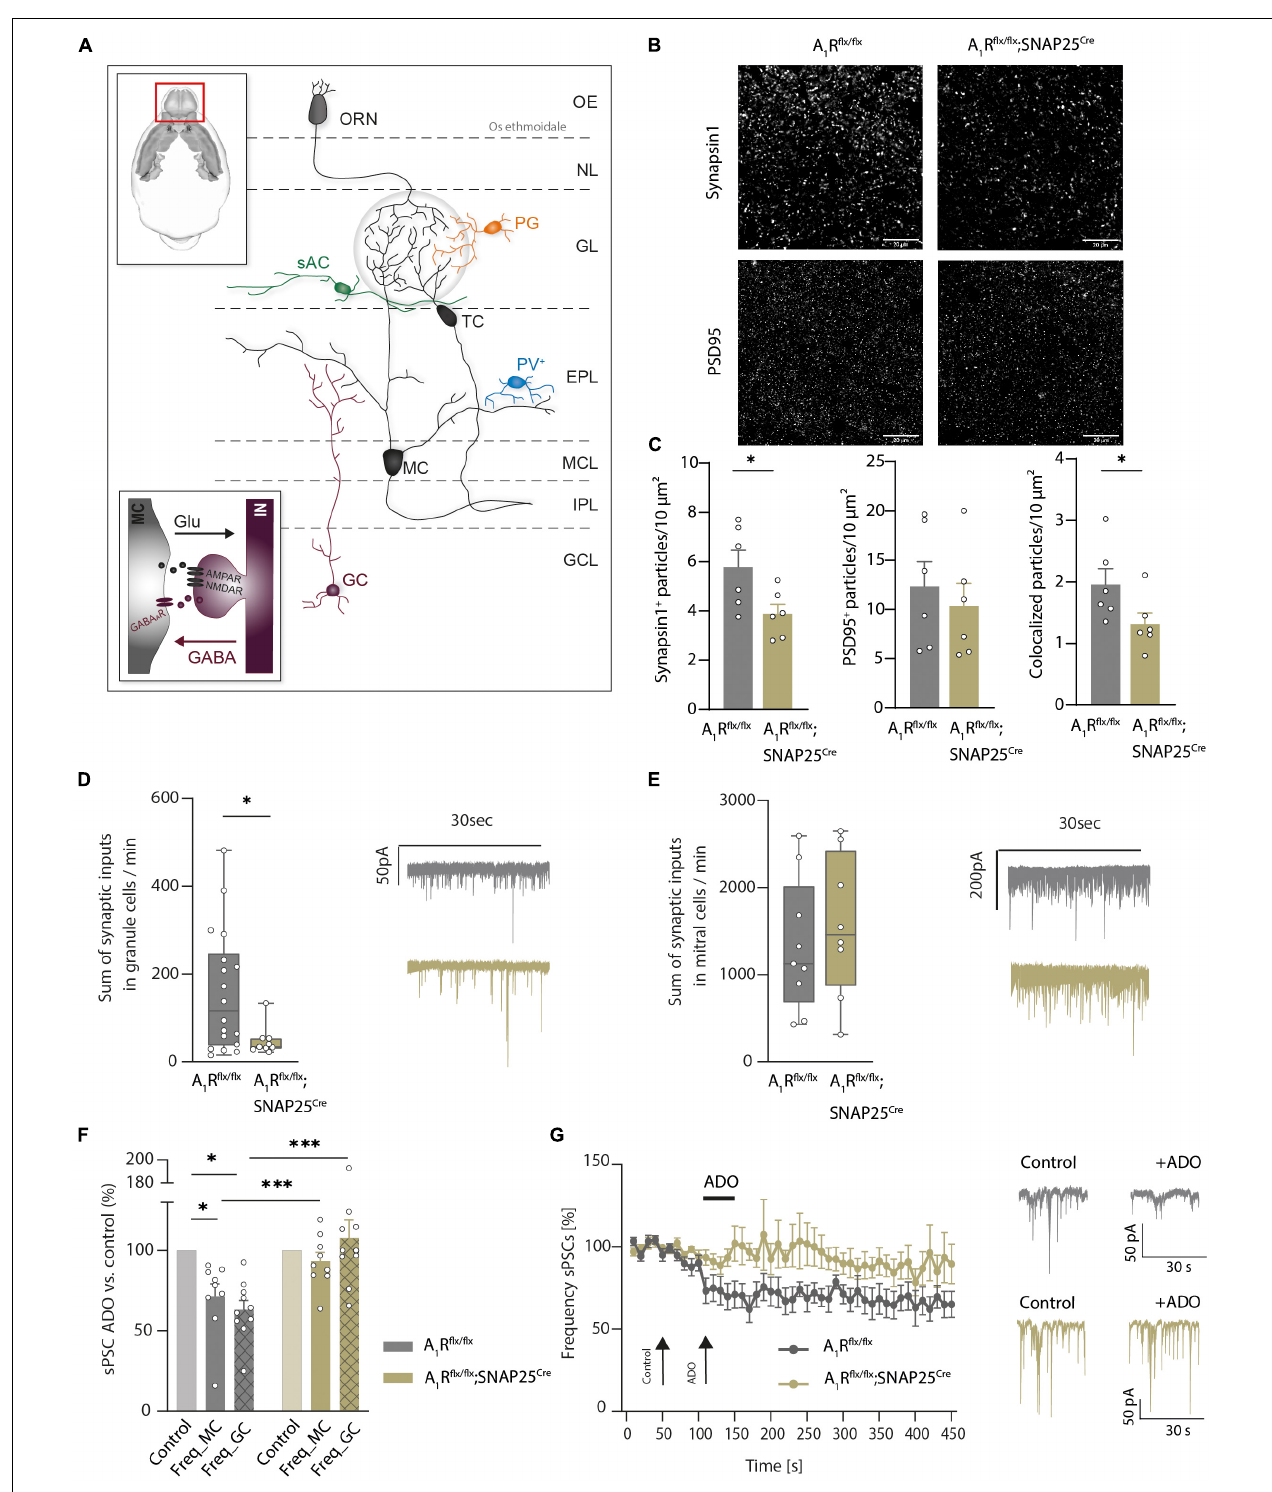
FIGURE 2 | Adenosine modulates microcircuits in the external plexiform layer of the main olfactory bulb via A 1 R. (A) Schematic presentation of main olfactory bulb with principal neurons (MC, TC) and local interneurons [periglomerular neurons (PG), short axon cells (sAC), parvalbumin neurons (PV), and granule cells (GC)]. Inset: Mechanism of dendro-dendritic signaling at the reciprocal MC-GC synapse. (B) Representative images of synaptic density in the external plexiform layer (EPL) of the